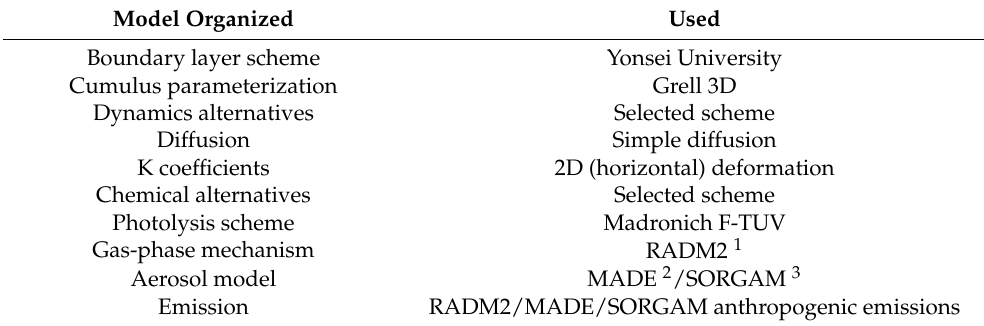
Table 1. Cont. Model Organized Used Boundary layer